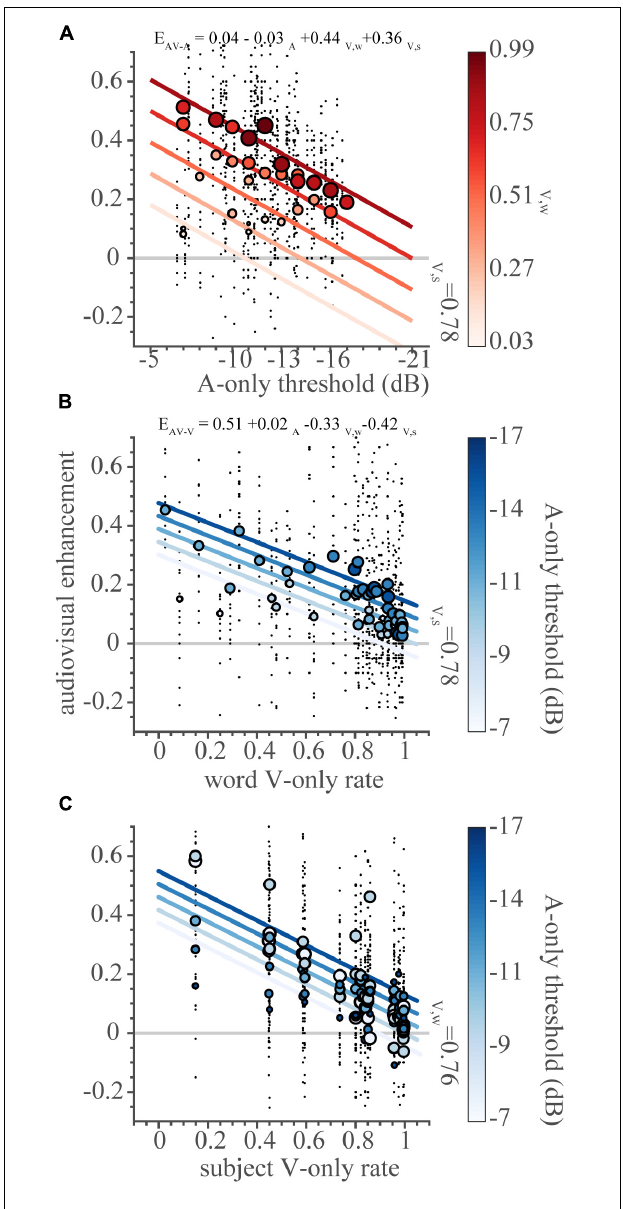
FIGURE 8 | Inverse effectiveness. The audiovisual enhancement over unisensory responses (as defined in the text) as a function of the independent variables (A) auditory threshold, (B) visual word recognition rate, (C) visual subject recognition rate. Note that the x -axis is inverted in (A) . Black dots indicate the enhancement in correct score for every subject-word-SNR combination. To visualize the effects of the three independent variables on the dependent variable, we binned the variables as follows. The two-dimensional bins were centered on rounded threshold values and for five visual word recognition rates (from the minimum to the maximum rates in equidistant steps) in (A) , and on five auditory thresholds (from the minimum to the maximum thresholds in equidistant steps) and all visual word recognition rate values in (B) and visual subject recognition rates in (C) . Circles denote binned average correct scores. Lines indicate the best-fit multiple regression lines for the independent variable of interest (on the abscissa), with intercepts determined by the second, binned variable (indicated by the color bar) and the mean of the third variable (indicated by text). Dot size (color) denotes the cross-sensory performance level (as indicated by the color